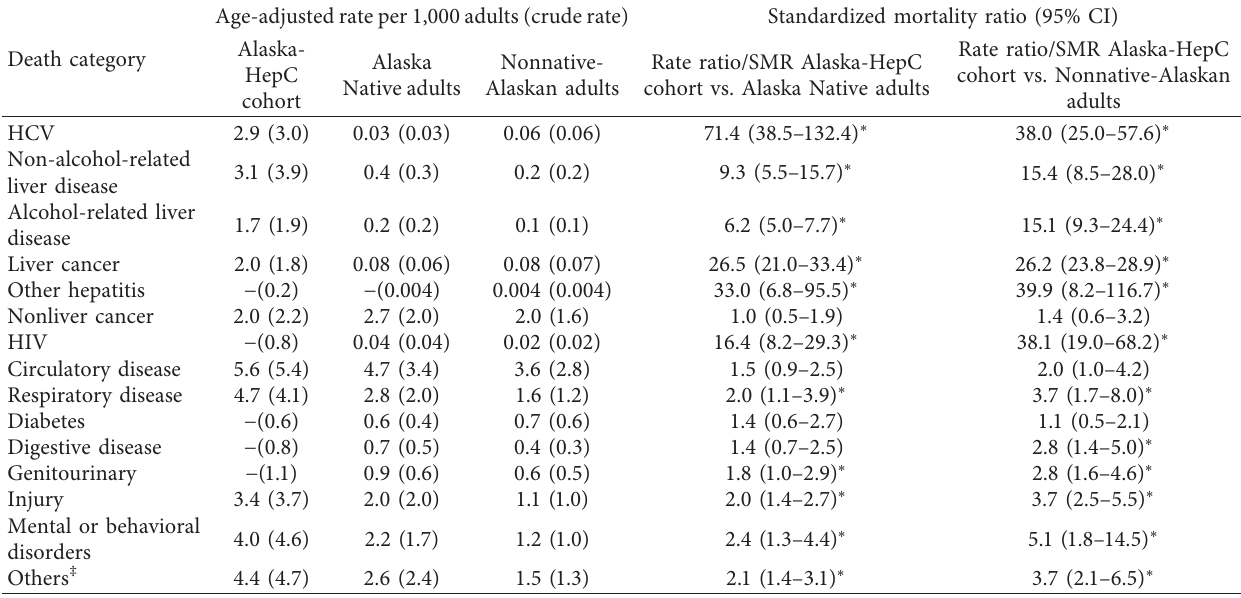
Table 3: Comparing age-adjusted rate of multiple causes of known deaths between the Alaska-hepatitis C cohort in Alaska and Alaska Native and Nonnative adults in Alaska, 1995–2016.